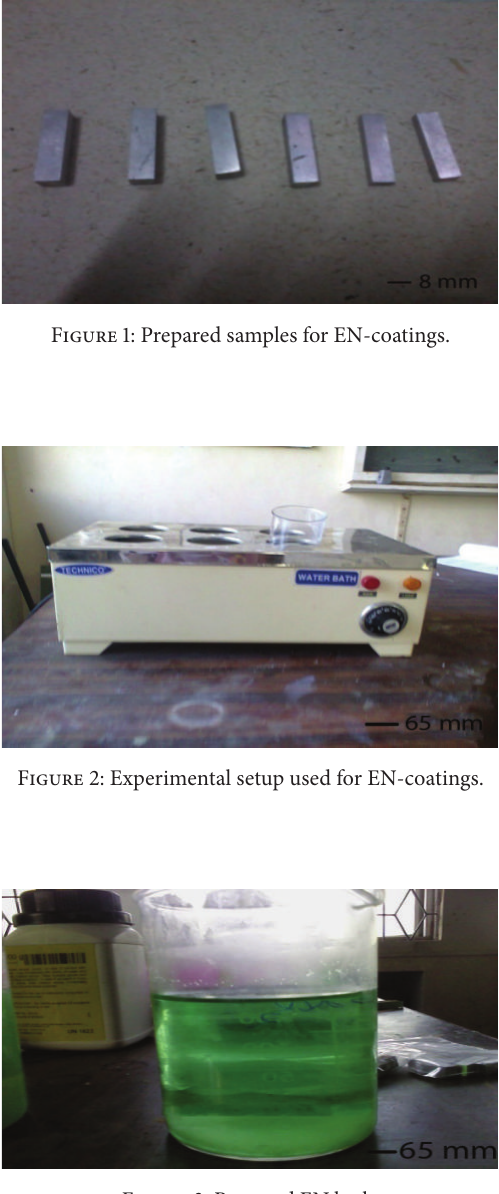
Figure 3: Prepared EN bath.